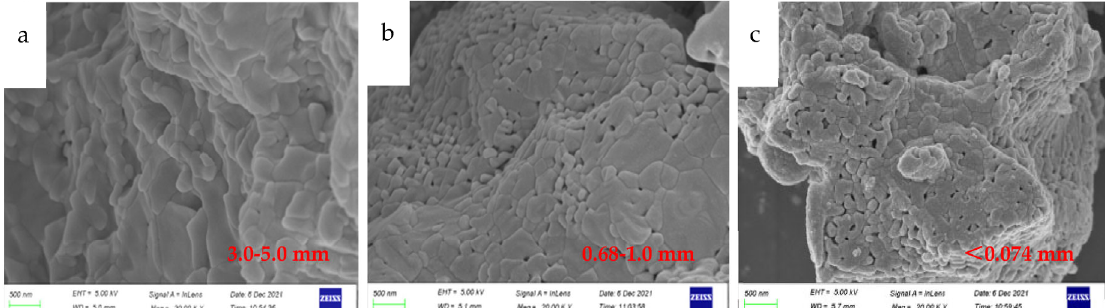
Figure 7. Microstructure of calcined limestone with different particle size. Microstructure of limestone particles with a particle size range of 3.0–5.0 mm for ( a ). Microstructure of limestone particles with a particle size range of 0.68–1.0 mm for ( b ). Microstructure of limestone particles with particle size less than 0.074 mm for ( c ).